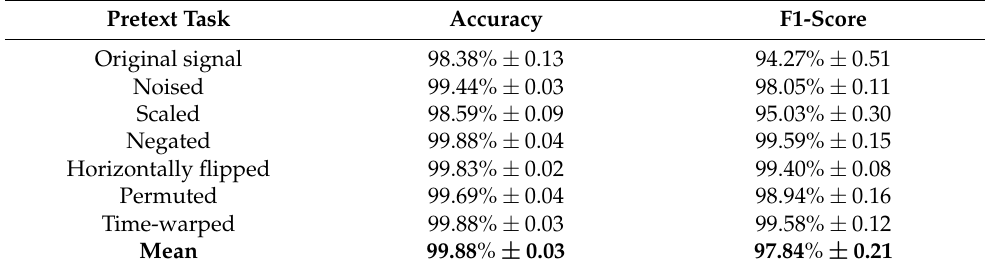
Table 5. Accuracy and F1-score results for the pretext tasks selected for self-supervised training.